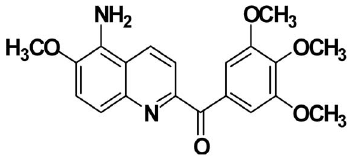
Figure 1. Chemical structure of 5-amino-6-methoxy-2-(3 9 ,4 9 ,5 9 - trimethoxybenzoyl)-quinoline